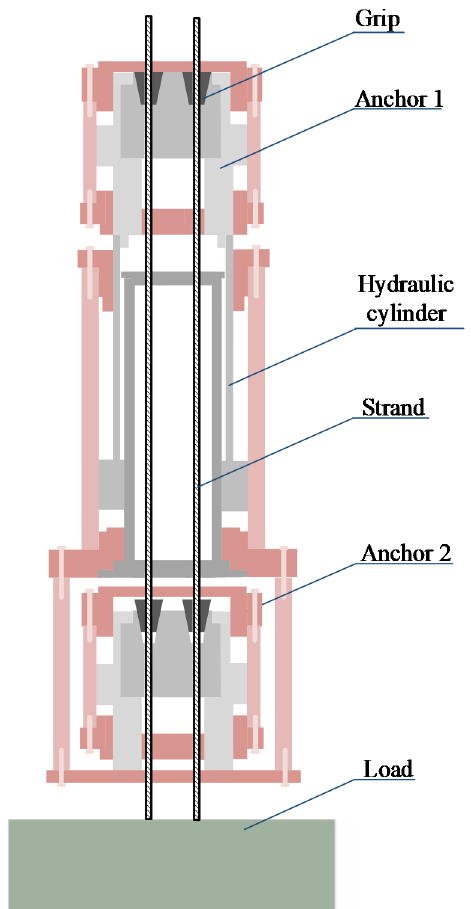
Figure 1. Structure of strand jack.